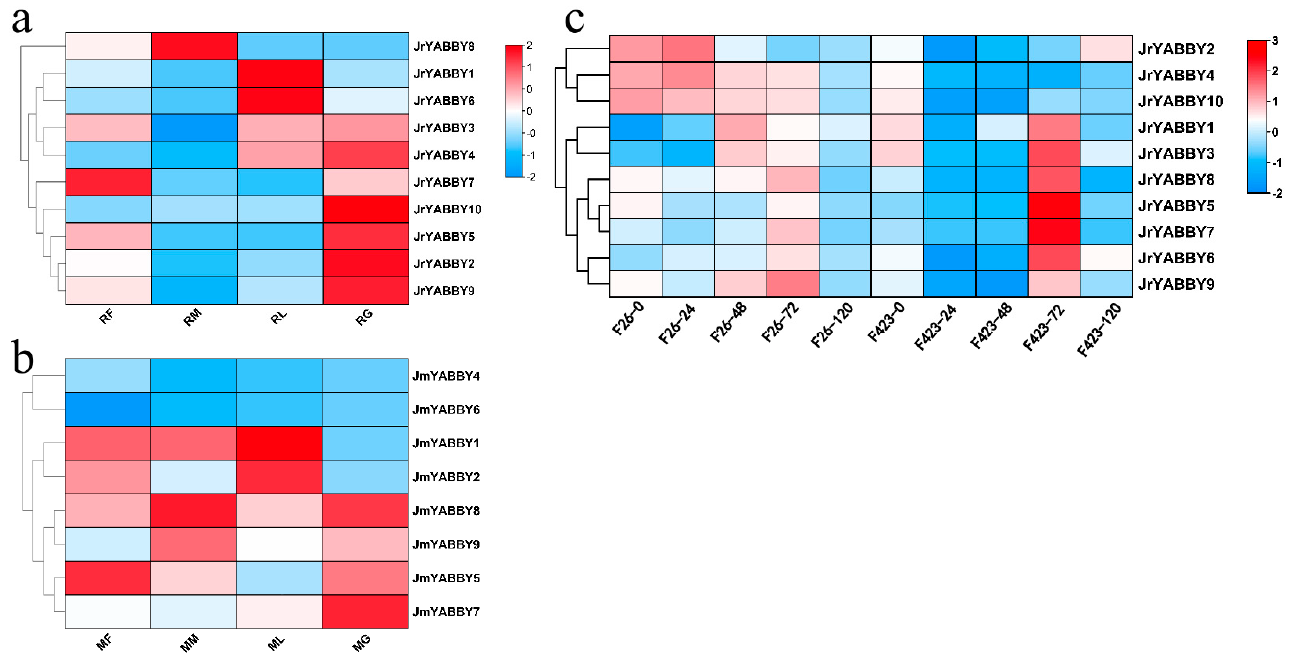
Figure 6. Expression patterns of YABBY genes in J. regia and J. mandshurica . ( a ) Expression patterns of identified YABBYs in female flowers, male flowers, leaves, and green pericarps of J. regia .; RF, female flowers of J. regia ; RM, male flowers of J. regia ; RL, leaves of J. regia ; RG, green pericarp of J. regia . ( b ) Expression patterns of identified YABBYs in female flowers, male flowers, leaves, and green pericarps of J. mandshurica . MF, female flowers of J. mandshurica ; MM, male flowers of J. mandshurica ; ML, leaves of J. mandshurica ; MG, green pericarps of J. mandshurica . ( c ) Expression patterns of identified YABBY genes in J. regia under biotic stress. F26 indicates anthracnose-resistant varieties, F423 indicates anthracnose-susceptible varieties. Numbers after ‘-’ represent time after infection (unit: hour). Colored scale reflects gene expression levels.